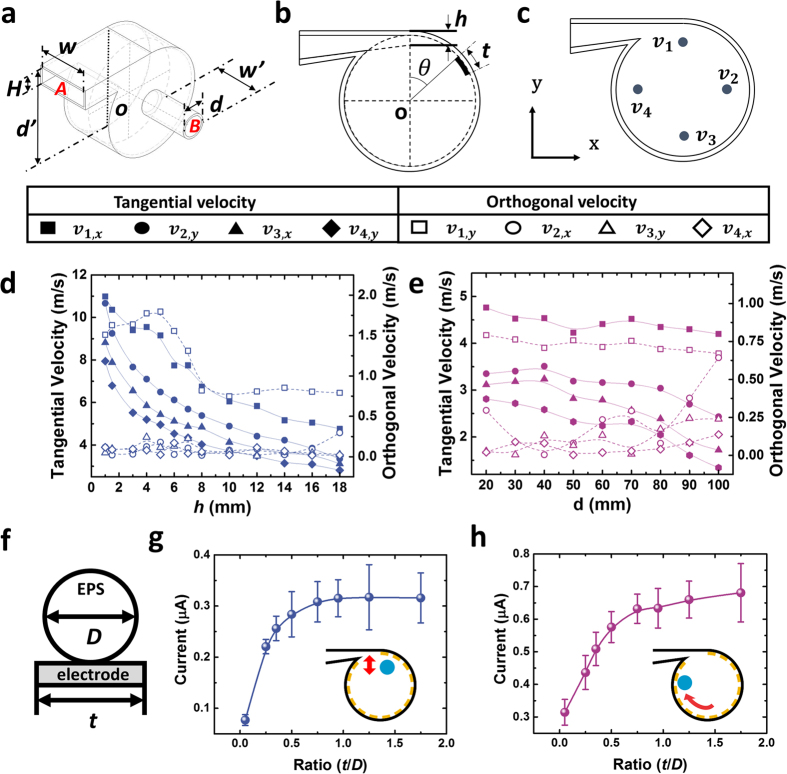
Computational fluid dynamics results of the WR-TENG and output based on the sphere-electrode size ratio.(a) A 3-D model used in the simulation, and (b) Various parameters used in the optimization. (c) The wind velocity measured points using CFD. (d) Tangential and orthogonal wind velocities calculated depending on the height of the throat, and (e) the outlet diameter. (f) The simplified structure and parameters used in the sphere-electrode size ratio. (g) Bouncing, and (h) rolling ICC outputs based on the sphere-electrode size ratio.